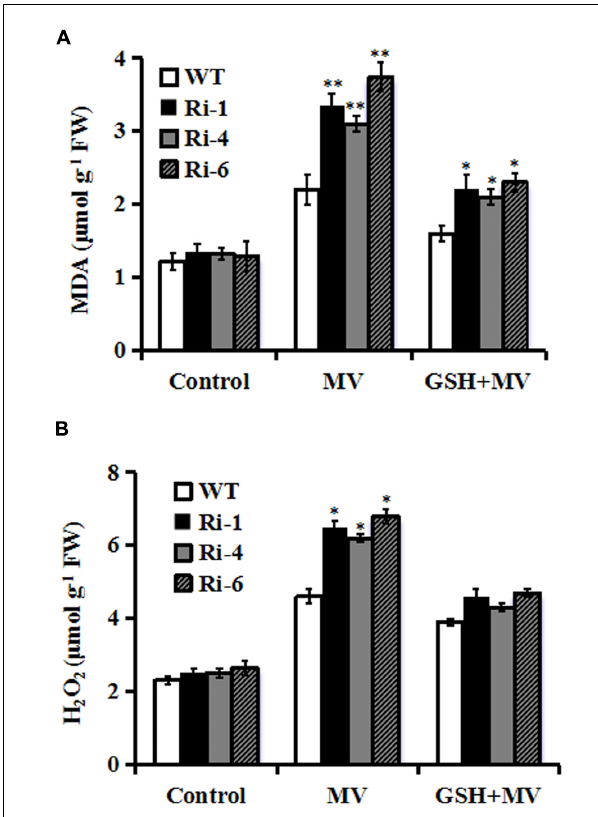
FIGURE 4 | Changes of MDA and H 2 O 2 in SiR RNAi lines under oxidative stress. (A) Determination of MDA accumulation in leaves of WT and three RNAi lines 3 days after MV (20 µ M) or GSH (10 mg/L) plus MV(20 µ M) spraying. (B) Quantitative determination of H 2 O 2 accumulation in leaves of WT and three RNAi lines 3 days after MV (20 µ M) or GSH (10 mg/L) plus MV (20 µ M) spraying. In both (A,B) , each experiment was repeated twice. Bar indicates SE. Values are mean ± SE. ∗∗ t -test, with P < 0.01; ∗ t -test, with P < 0.05.